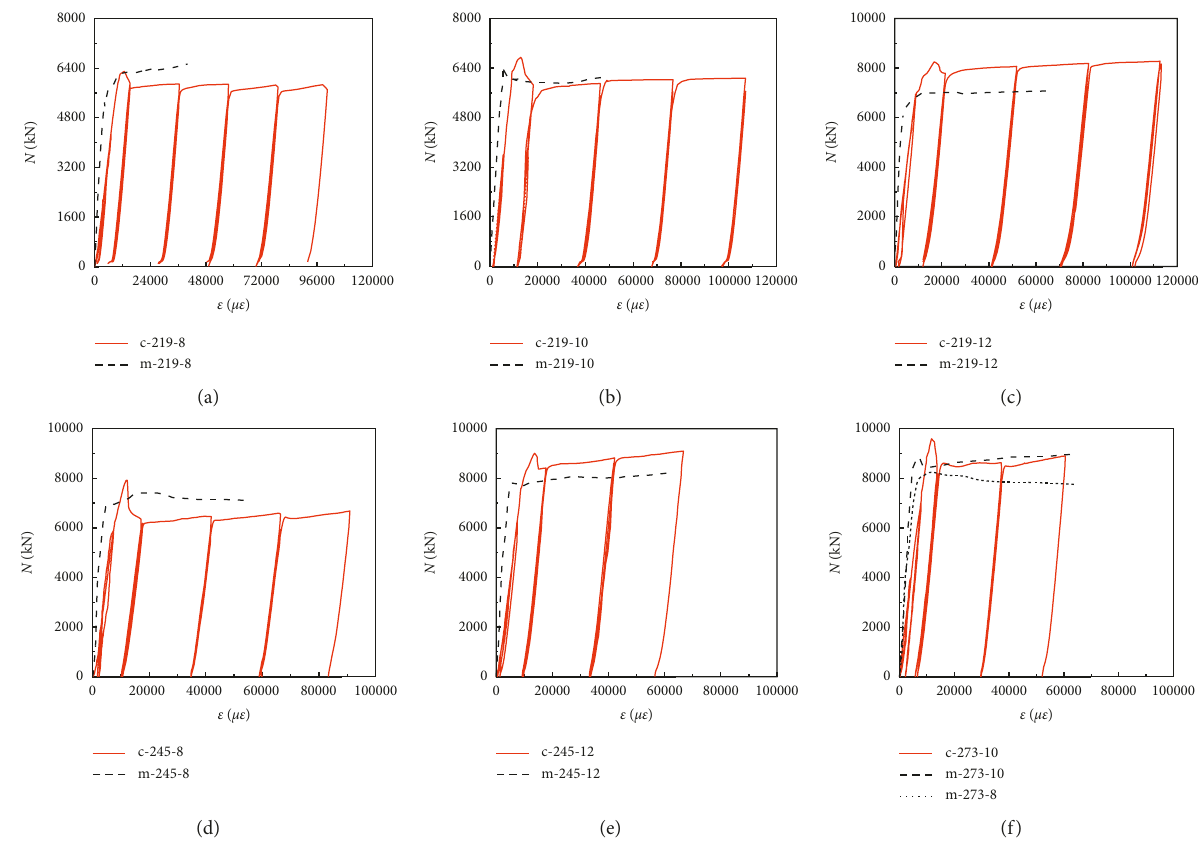
Figure 5: Load-strain curves of RFCT columns (for column designations, refer Table 1). (a) 219-8. (b) 219-10. (c) 219-12. (d) 245-8. (e) 245-12. (f) 273-8/10.